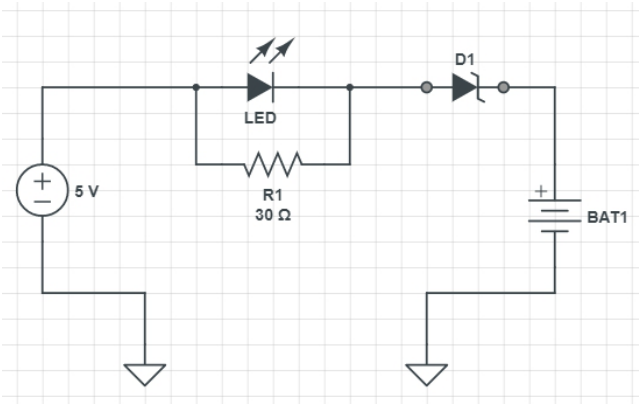
Figure 18. Circuit diagram of the energy storage system .